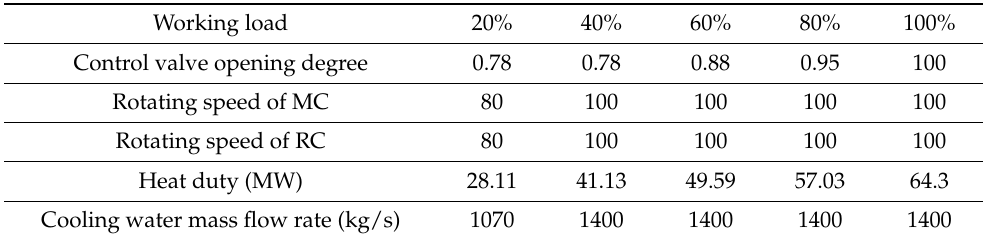
Table 7. Corresponding parameters of each working